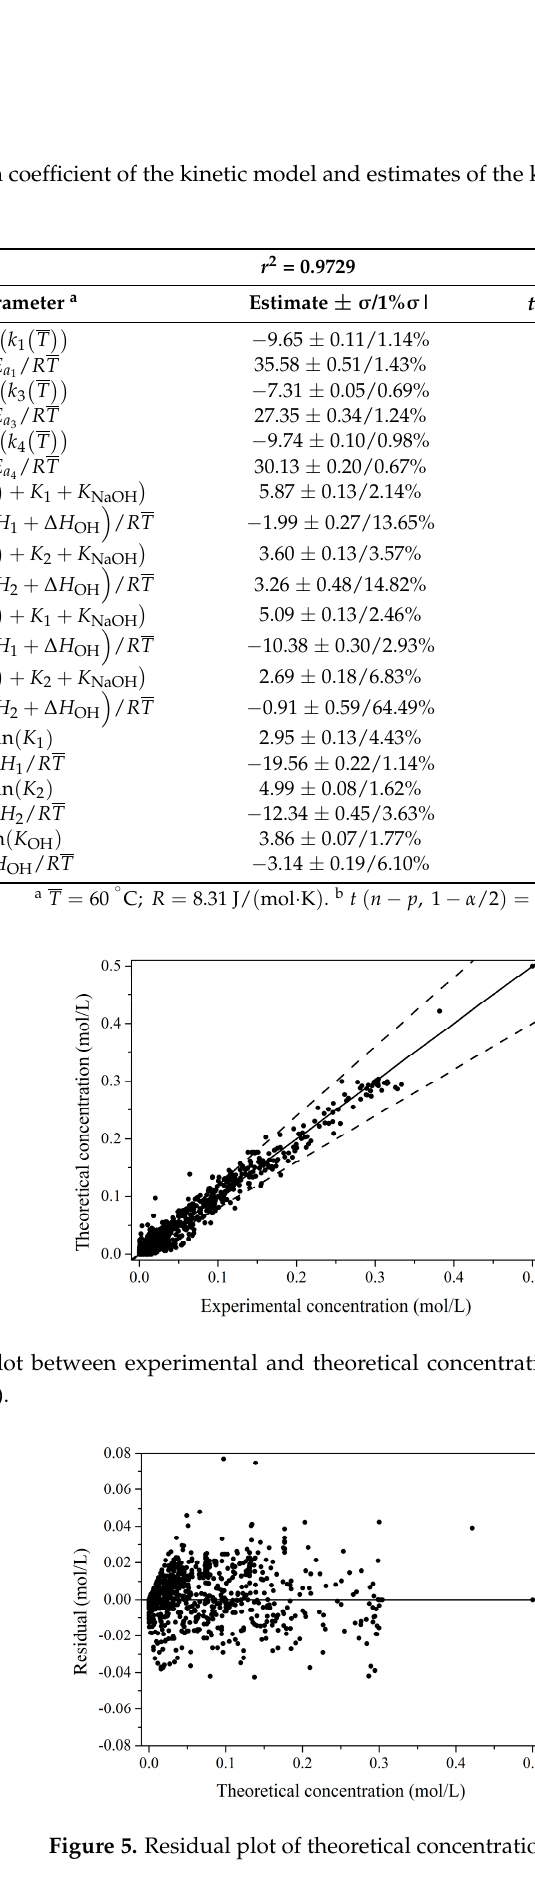
Table 2. Regression coefficient of the kinetic model and estimates of the kinetic parameters using all experimental data.